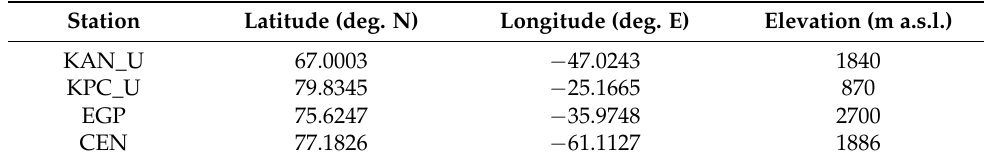
Table 1. Automatic weather station used for the investigation of surface melt. Station Latitude (deg. N) Longitude (deg. E) Elevation (m a.s.l.) KAN_U 67.0003 − 47.0243 1840 KPC_U 79.8345 − 25.1665